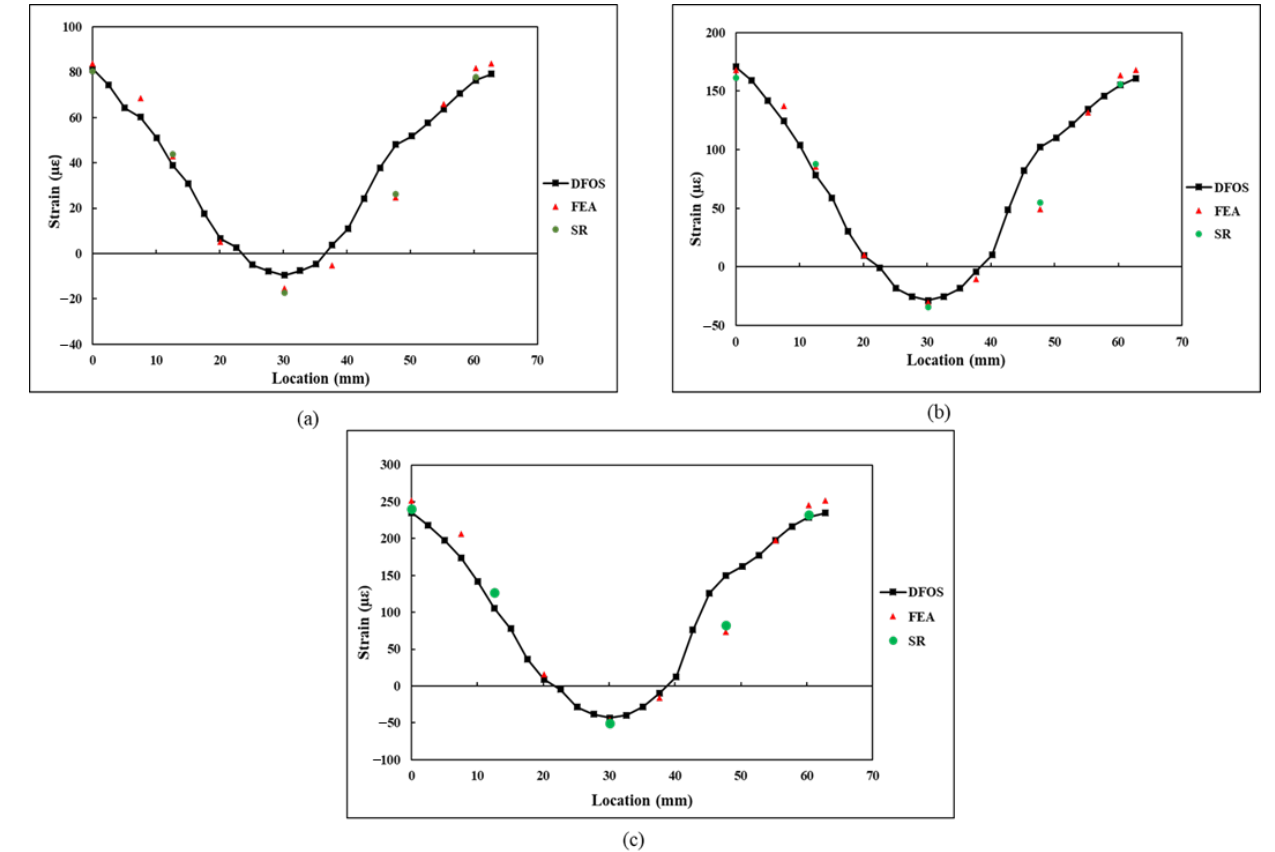
Figure 18. Comparison of the 𝜀 𝑛1 − 𝜀 𝑛10 values obtained in tensile specimen at a loading of: ( a ) 5 kN; ( b ) 10 kN; ( c ) 15 kN.